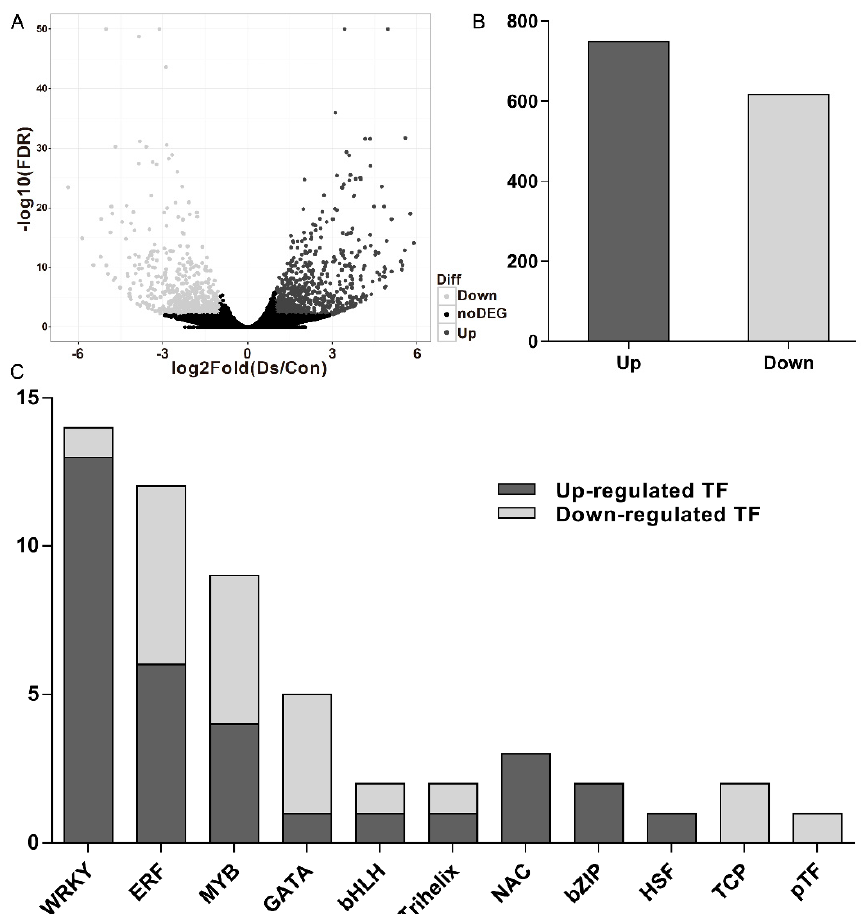
Figure 1. Differentially expressed genes ( p -value < 0.05 and fold-change > 2.0) in response to incubation with the culture filtrates of D. seriata 98.1 at 3 dpi compared with mock control. ( A ) Distribution of gene expression levels. The dark grey dots represent more prevalent transcripts in incubated cells than control while lower frequency represented by light grey dots and transcripts showing no significant differences were represented by black dots. ( B ) The number of up-regulated and down-regulated genes in the incubated cells. ( C ) Differentially expressed transcription factors families of cells incubated.